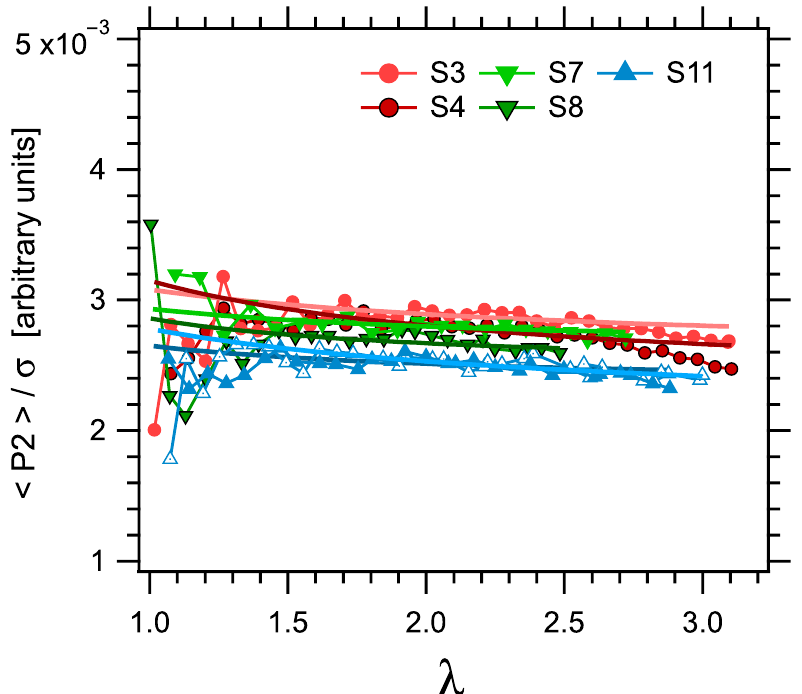
Figure 15. The ratio (cid:104) P 2 (cid:105) / σ as a function of the elongation parameter λ in a set of samples limited to those with higher apparent crosslink densities (higher D res values). The stress-optical law would correspond to a constant ratio. The absolute values of the ratio are arbitrary, as the anisotropy parameter (cid:104) P 2 (cid:105) deduced from X-ray scattering is proportional to the segmental order parameter, with a proportionality factor which is not known quantitatively. Symbols are measurements, curves correspond to Mooney–Rivlin fits of the stress and orientation